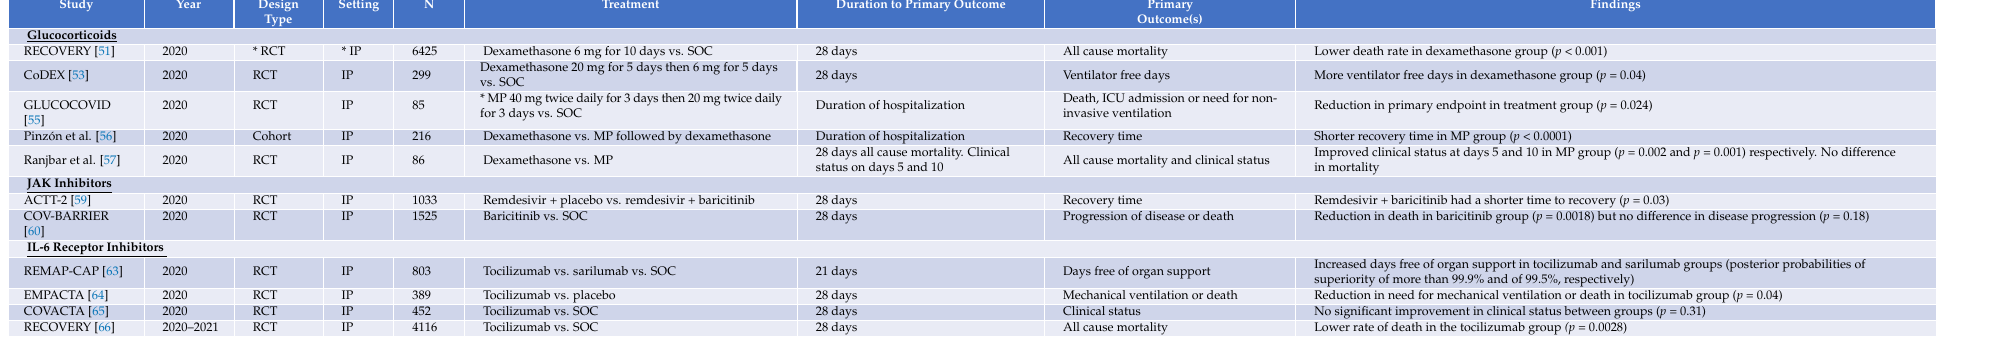
Table 2. Studies Evaluating the Effect of Currently Used Treatments Targeting the Inflammatory Response Caused by the SARS-CoV-2